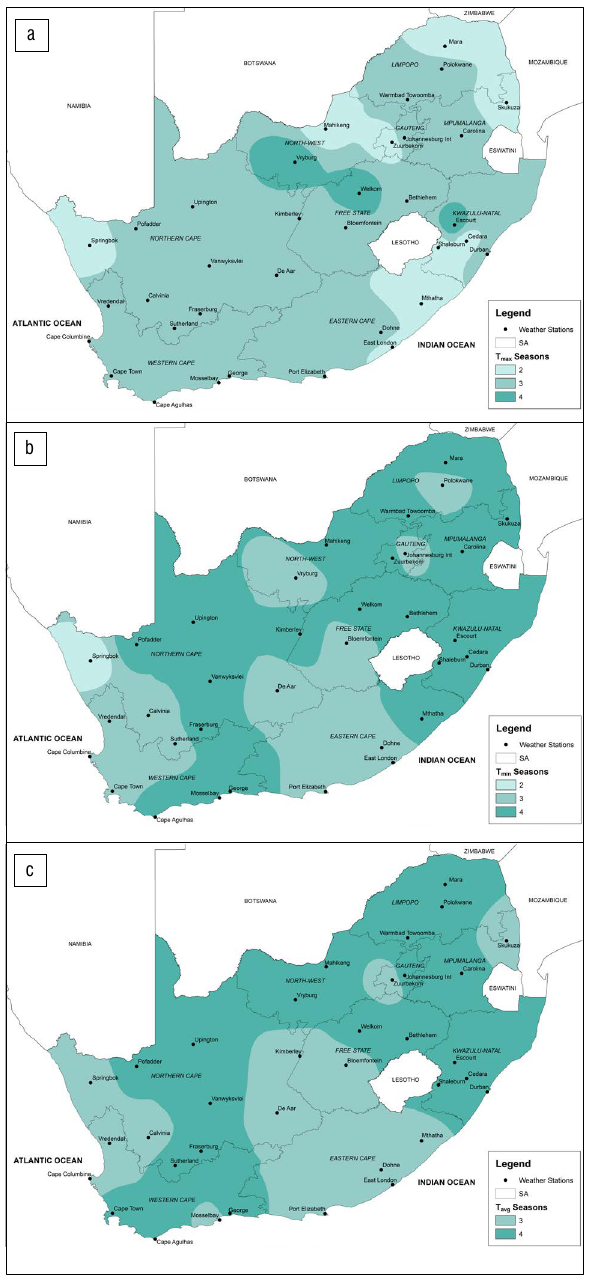
), (b) minimum (T max